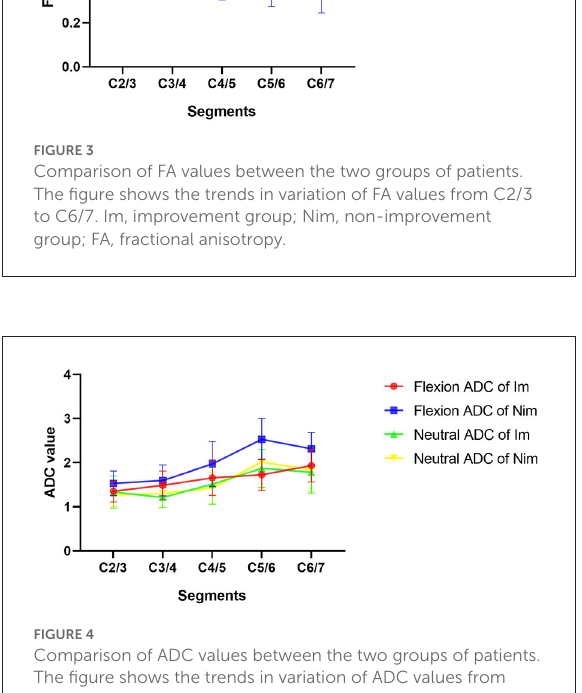
FIGURE4 Comparison of ADC values between the two groups of patients. The figure shows the trends in variation of ADC values from